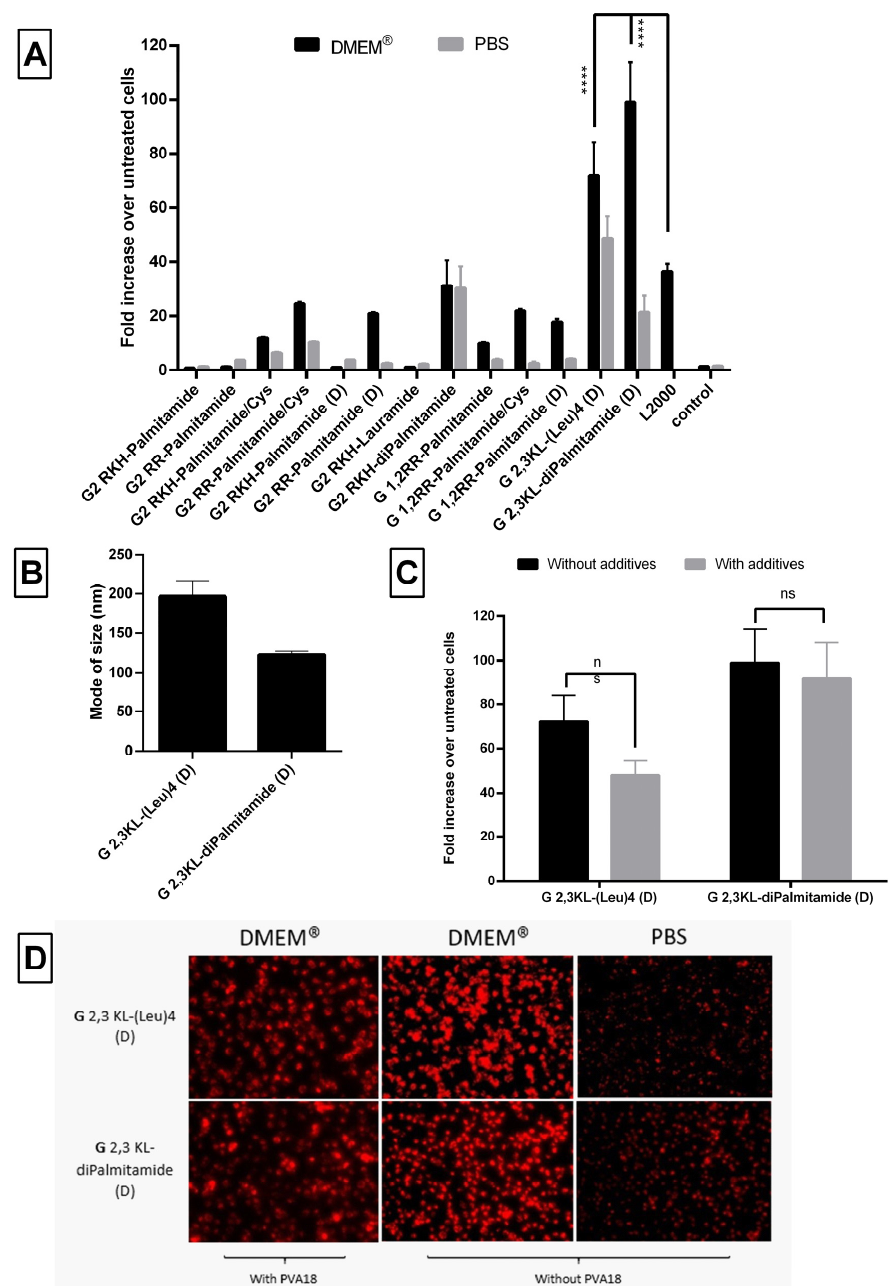
Figure 10. Evaluation of the behavior of the lipophilic peptide dendrimer/ON complexes. ( A ) Fold increase in luciferase signals after transfection of the HeLa Luc/705 cells in serum-containing media. ( B ) Mode of size (nm) of selected dendrimers formulated in DMEM ® . ( C ) The effect on transfection of HeLa Luc/705 reporter cells in serum-containing media with lipophilic peptide dendrimer/ON complexes formulated in DMEM ® in presence of the polymeric excipient PVA 18. ( D ) Cellular uptake after transfection in serum-containing media of the selected 3rd generation peptide dendrimers/Alexa- 568-labelled ON complexes in HeLa Luc/705 cells. Dendrimers were formulated with PVA18 in DMEM ® and without PVA18 in DMEM ® and PBS and incubated for 24 h, at 37 ◦ C in a humidified incubator with 5% CO 2 . Live cells were rinsed with DMEM ® with no phenol red (Invitrogen), before imaging with the fluorescence microscope (Olympus IX81). (magnification 20 × , Scale bar = 100 µ m. Fold increase in luciferase activity: RLU normalized by the total amount of protein and related to values for untreated cells. Each bar represents the mean with the SEM of at least three independent experiments performed in triplicate ( n ≥ 3). p -values were calculated by two-way ANOVA test and the statistical differences were measured using post hoc Fisher’s LSD test. (ns: non-significant, and **** p ≤